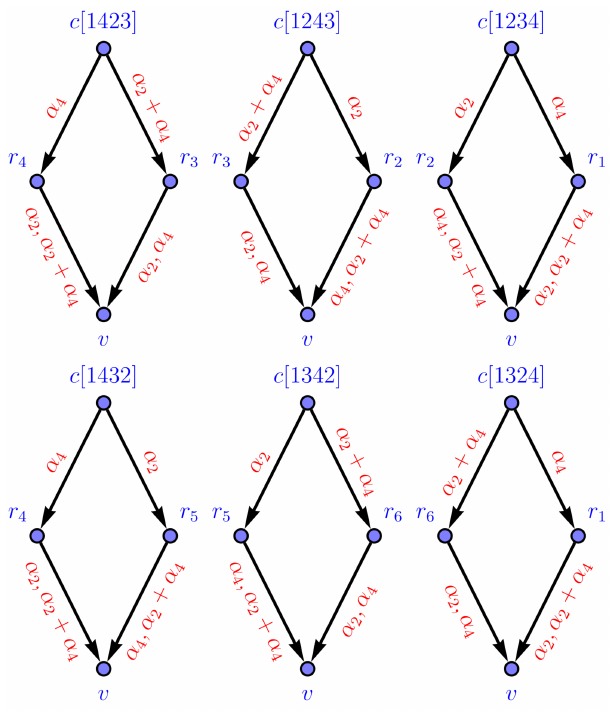
Figure 11 . The Hasse diagrams H [ P ( σ ) ] for all four-particle